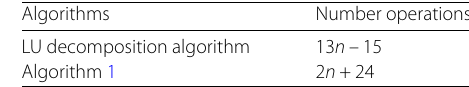
Table 1 Comparison of the total number operations for determinant of A